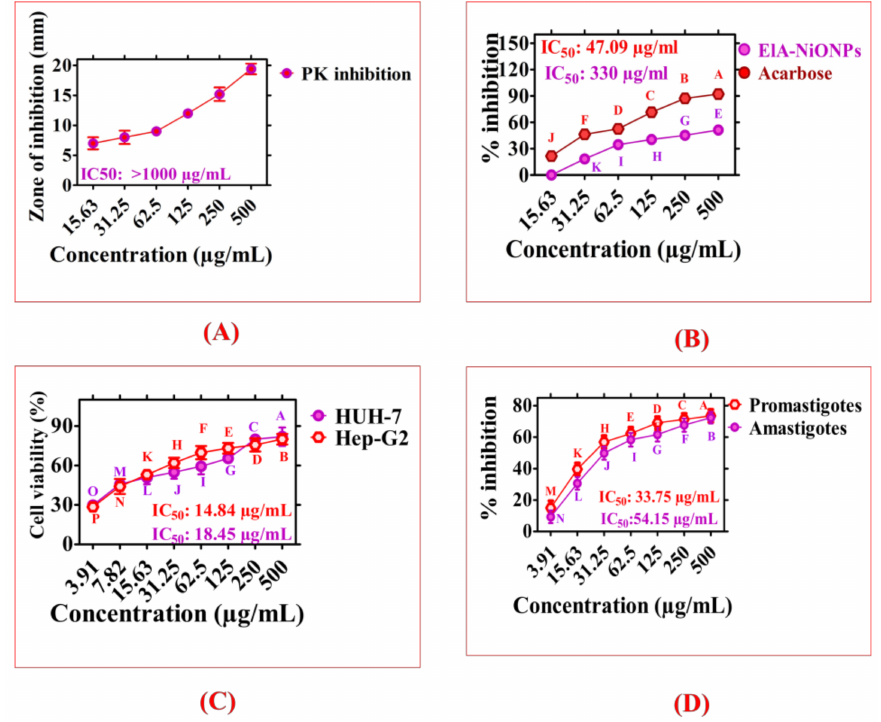
Figure 5. Enzyme inhibition and cytotoxic activities of ElA-NiONPs; ( A ) Protein kinase inhibitory studies; ( B ) Alpha-amylase inhibition; ( C ) Anticancer potentials of ElA-NiONPs; ( D ) Anti-leishmanial studies of ElA-NiONPs. Data represent the mean of three replicates, and each alphabet indicates significance at p <